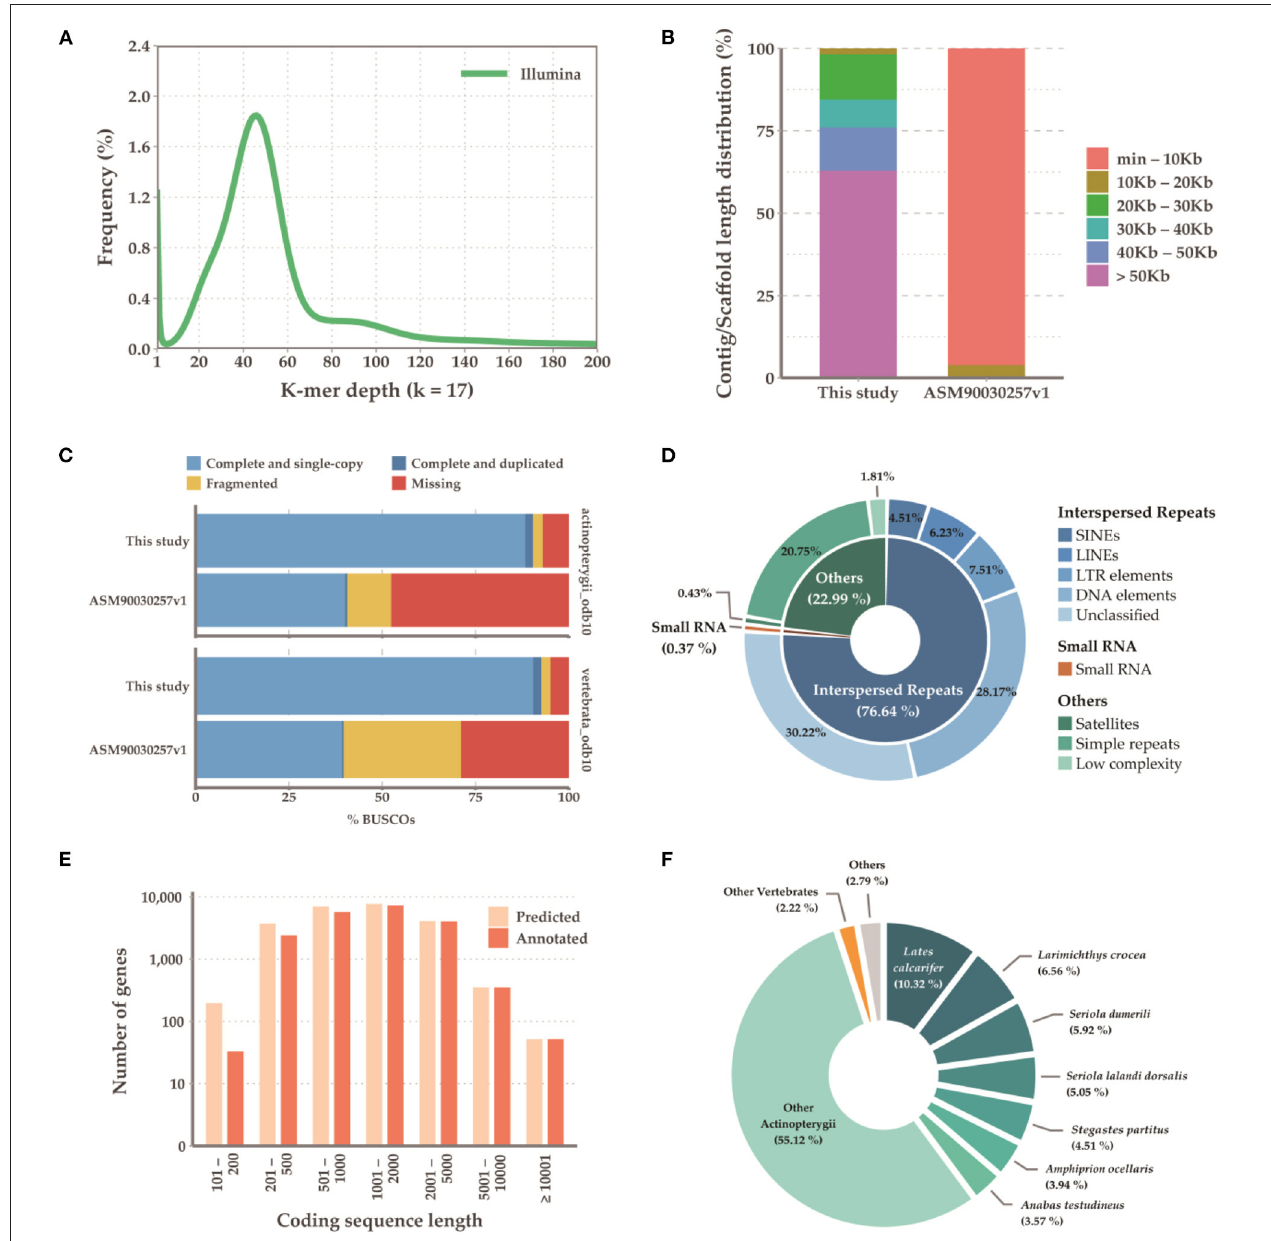
FIGURE 1 | Summary of the sequencing results. (A) Genome size estimation with illumina short reads; (B) Contig length distribution between current assembly and ASM90030257v1; (C) BUSCO result summary with actinopterygii and vertebrate; (D) Repeat summaries; (E) Annotation summary of predicted genes; (F) Species distribution of mapped sequences in annotation